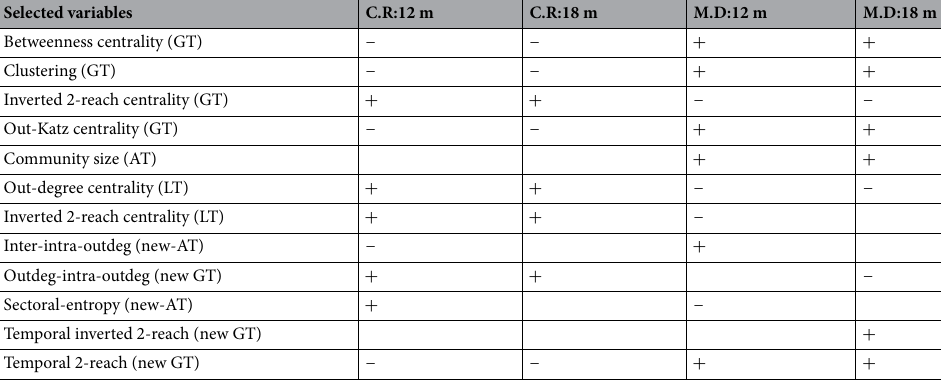
Table 3. Penalized multivariate regressions for system wide firm-based metrics, community-based metrics and community firm-based metrics. −, + denote the sign of the coefficient for significant variable. The variables not significant are not reported. The model is estimated by using Elastic Net regression. Each column corresponds to alternative definition of the dependent variable. In columns 1 and 2, the dependent variable is computed as cumulative returns over respectively 12 months and 18 months. In columns 3 and 4, the dependent variable is computed as the maximum drawdown over 12 months and 18 months, respectively.